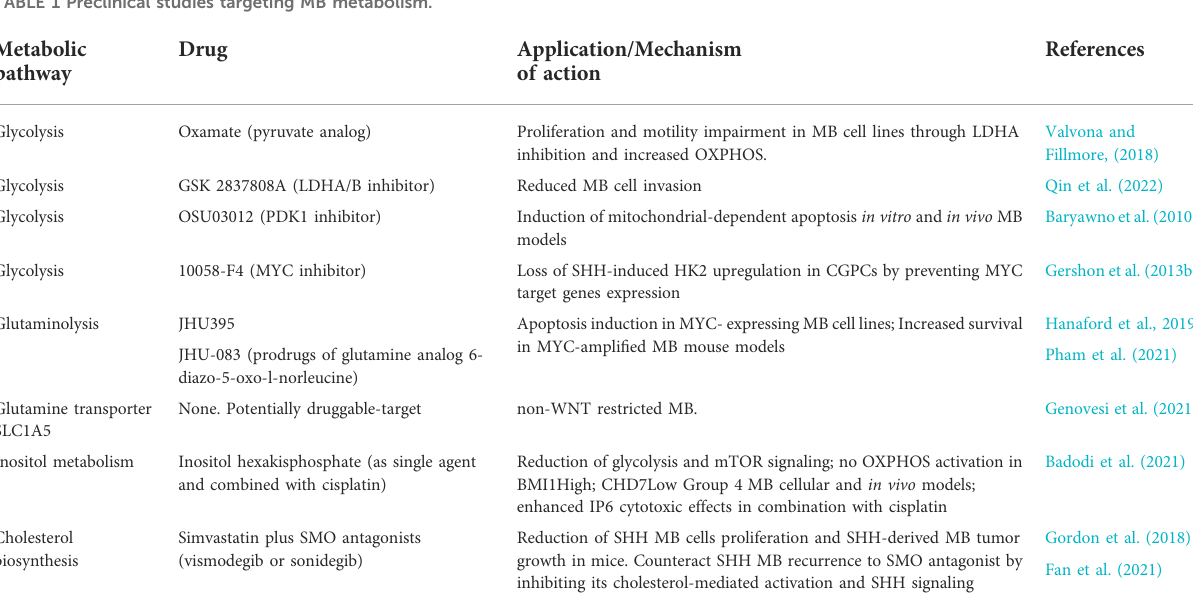
TABLE 1 Preclinical studies targeting MB